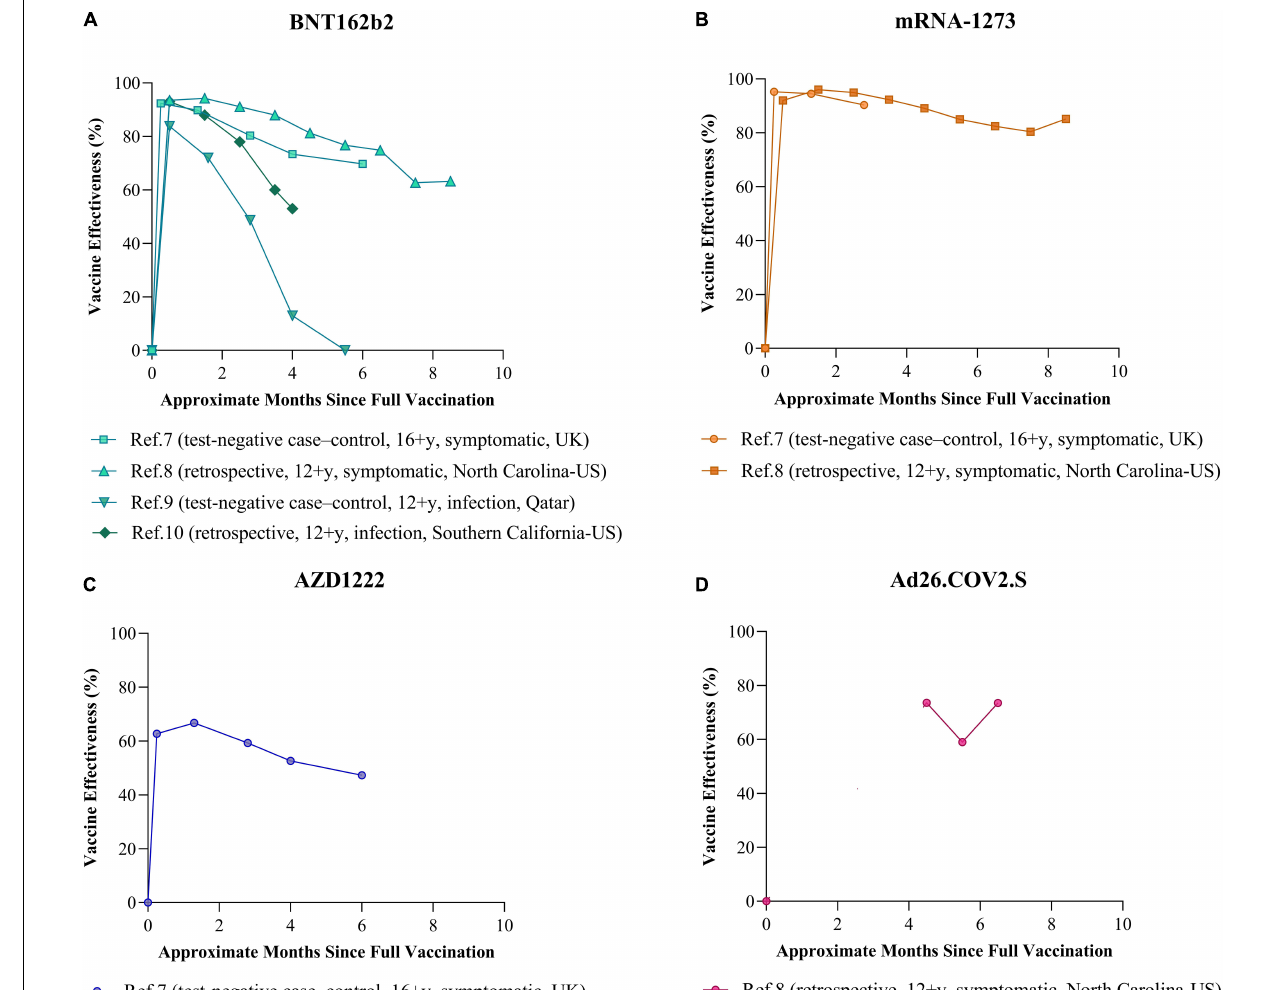
FIGURE 1 | Long-term VE against infection or symptomatic disease caused by SARS-CoV-2 Delta variant. The line chart shows the trends over time of the VE against infection or symptomatic disease caused by the Delta variant after two doses of (A) BNT162b2, (B) mRNA-1273, and (C) AZD1222 and one dose of (D) Ad26.COV2.S. The reference numbers in the figure are the same as those in the text. The study as reference 7 (Andrews et al., 2021) was conducted in population aged 16 and older in the United Kingdom using test-negative case–control design. The study as reference 8 (Lin et al., 2021) was conducted in population aged 12 and older in North Carolina, United States, using a retrospective design based on the COVID-19 Surveillance System. The study as reference 9 (Chemaitelly et al., 2021) was conducted in population aged 12 and older in Qatar using test-negative case–control design. The study as reference 10 (Tartof et al., 2021) was conducted in population aged 12 and older in Southern California, United States, using retrospective design based on the healthcare system. In this review, the VE data from references 7 and 8 were for symptomatic COVID-19 disease, while the data from reference 9 and 10 were for all monitored SARS-CoV-2 infections.